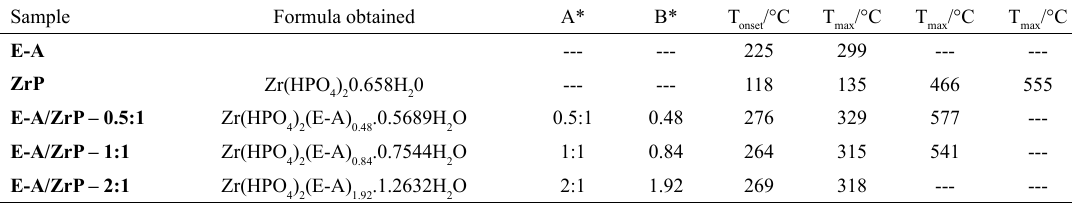
Table 3. TG/DTG data of the ZrP and modified zirconium phosphates. Sample